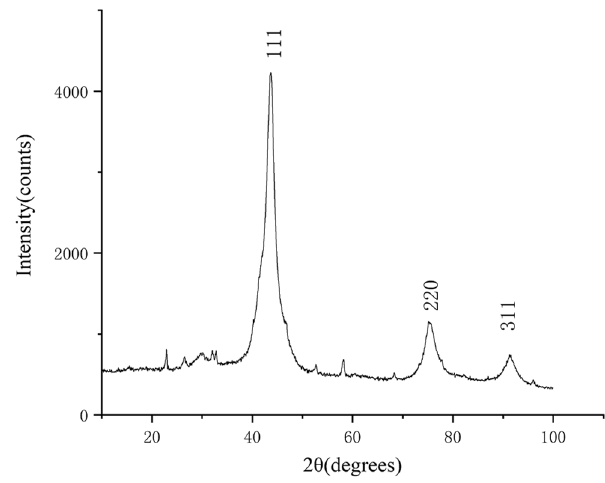
Figure 9. The XRD pattern of the purified product of the 20% MF experimental group. The horizontal